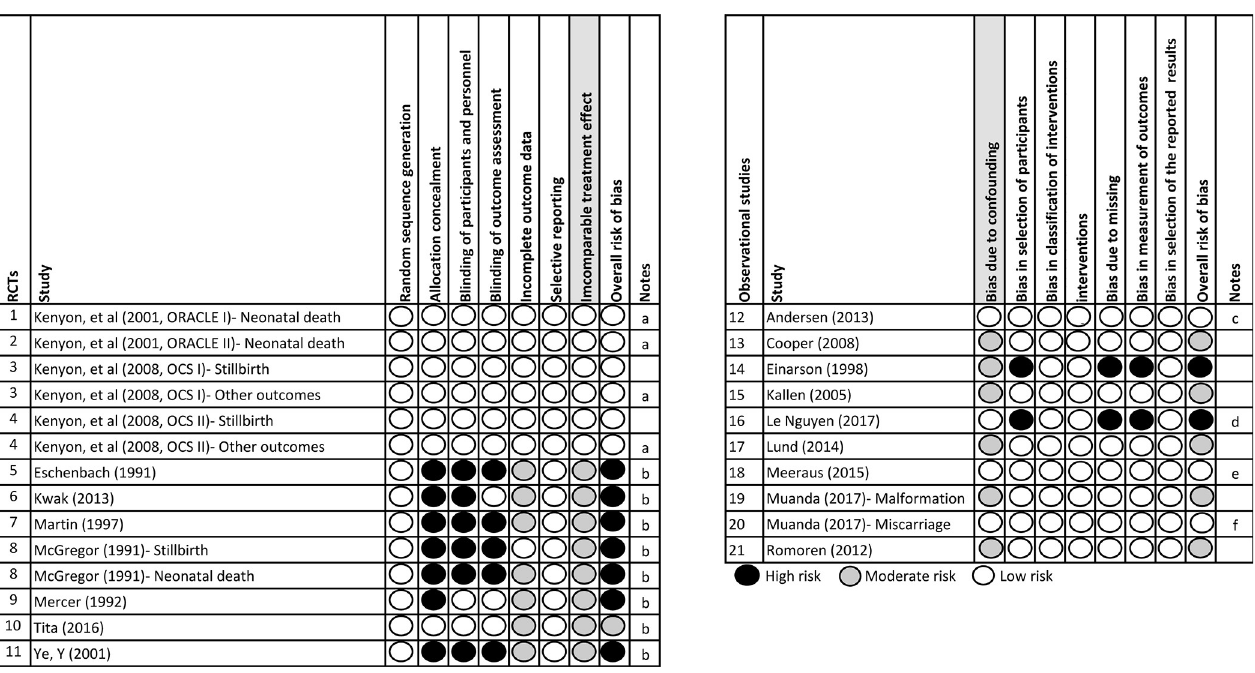
Fig 2. Assessment of bias. a: Evaluated as moderate risk in secondary analysis (low risk in primary analysis) due to incomparable treatment effect. b: Studies only eligible for secondary analysis. c: In the study of Andersen (2013), the OR was adjusted by maternal age, number of previous miscarriages, income and education. d: In the study of Le guyen, the OR was adjusted by maternal age, long-term illnesses, parity and multiple pregnancy. e: In the study of Meeraus (2015), the Hazard Ratio was adjusted by maternal age, Townsend quintile, year of delivery, smoking, alcohol problems, obesity, illicit drug use, treatment of chronic medical conditions and potentially neurologically-damaging infection during pregnancy. f: In the study of Muanda (2017), cases and controls were matched by gestational age and year of pregnancy; in the analysis of specific macrolides, the ORs were adjusted by 11 covariates, e.g. maternal age, education level, chronic comorbidities, maternal infections (urinary tract infection, respiratory tract infection, bacterial vaginosis and sexually transmitted infections) and prior exposure to antibiotics.